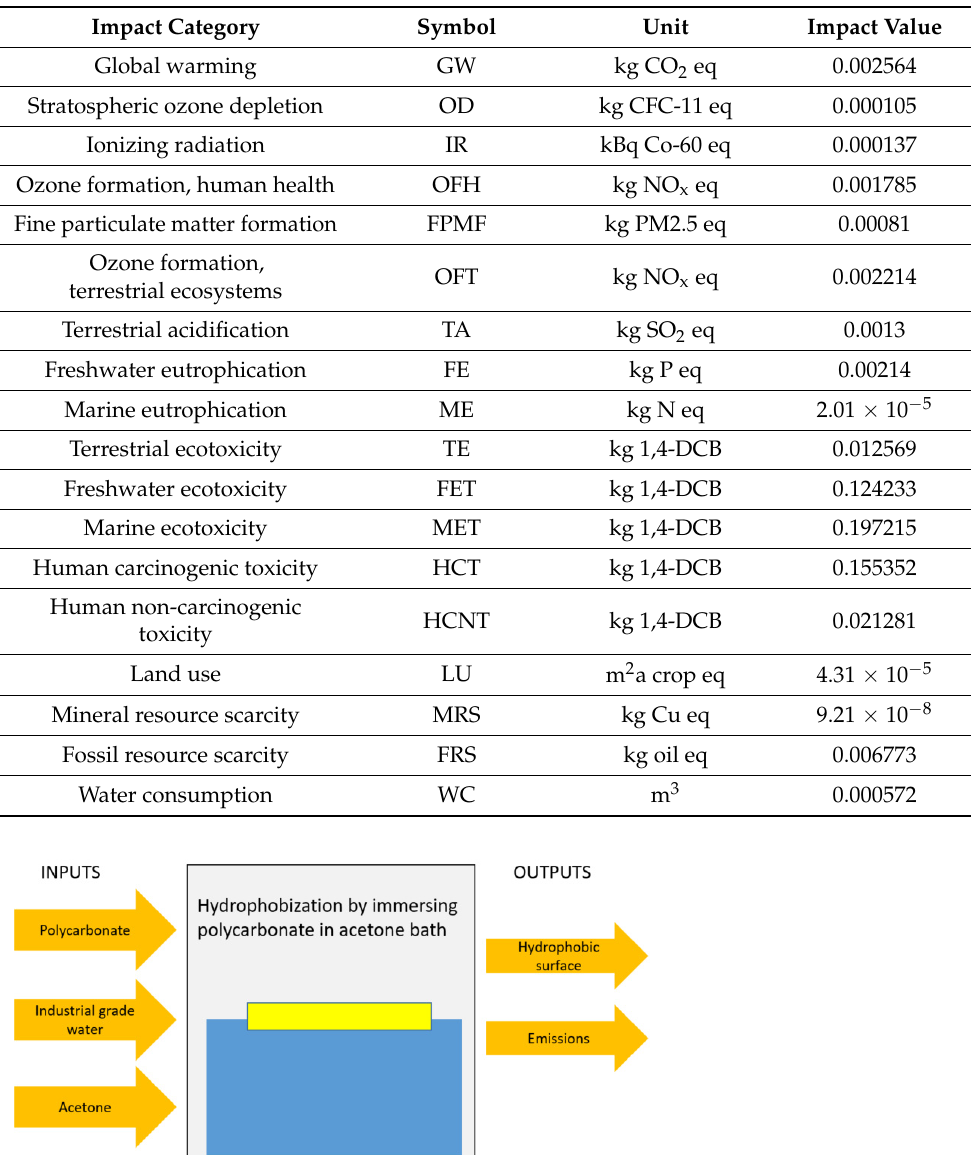
Table 2. LCA results for hydrophobization of polycarbonate via solution crystallization while using 30% acetone in the solution.